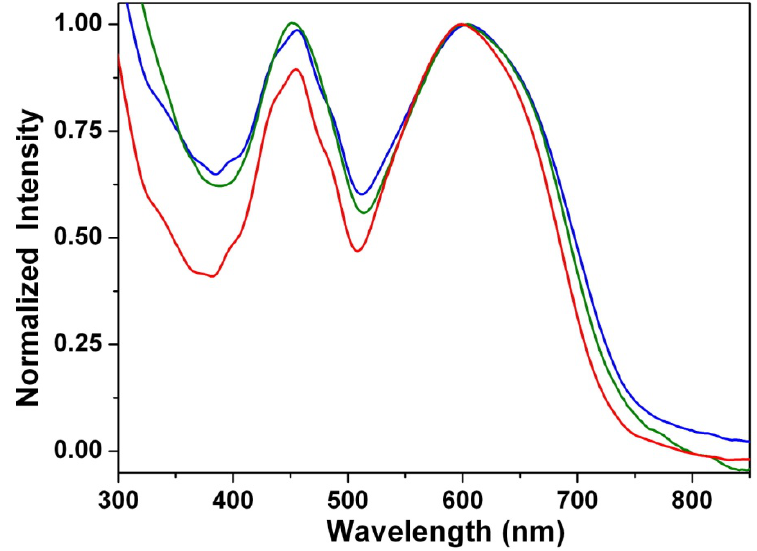
Figure 9. Normalized absorption spectra of 1a (blue line), 1b (green line) and 1c (red line) in neat film.